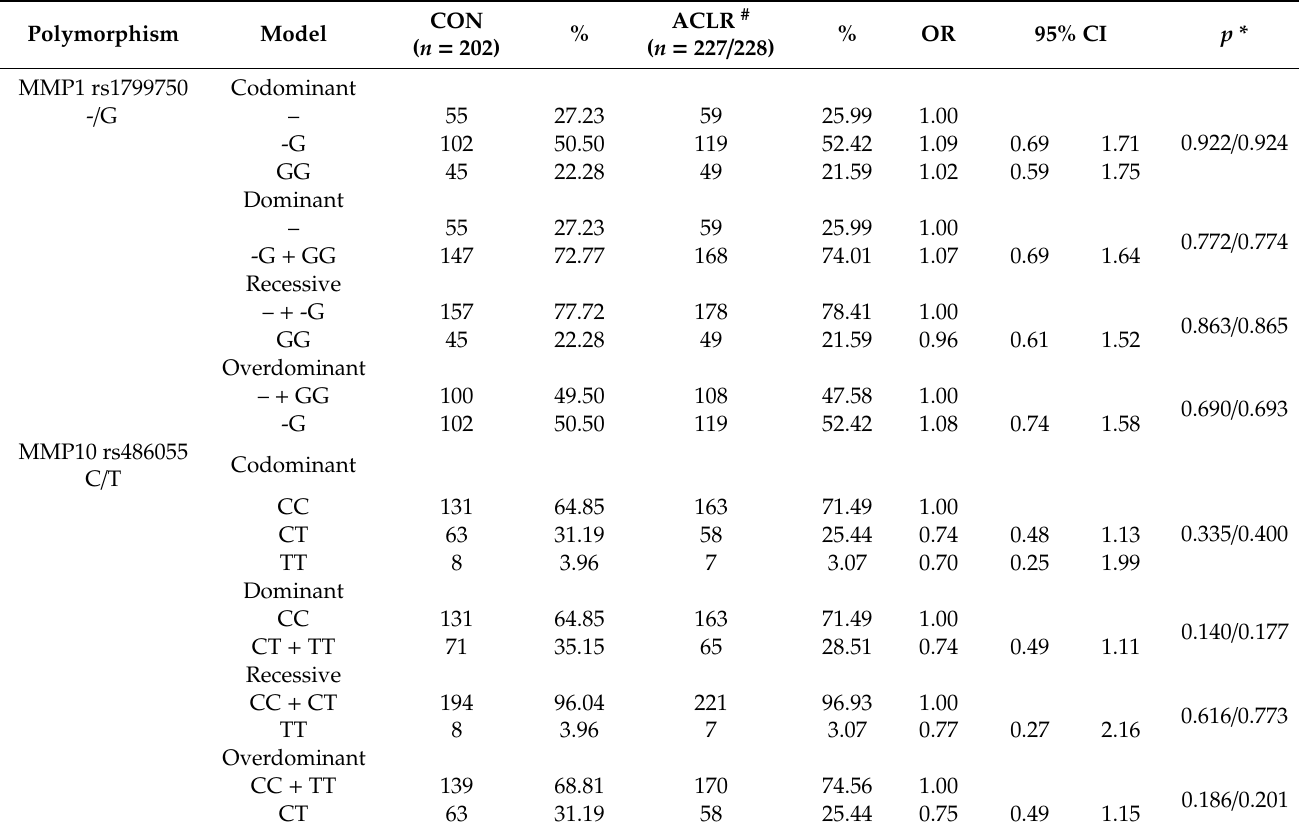
Table 2. Association analysis of the MMP1 rs1799750 - / G, MMP10 rs486055 C / T and MMP12 rs2276109 T / C polymorphisms with non-contact anterior cruciate ligament (ACL)